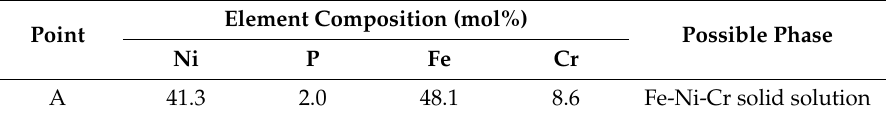
Table 2. Chemical composition of point A in brazed joint.